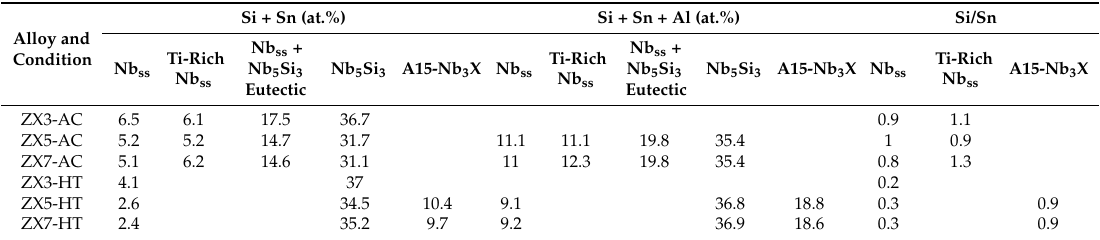
Table 6. Comparison of Nb ss , Ti-rich Nb ss , Nb 5 Si 3 , Nb ss + Nb 5 Si 3 eutectic, and A15 phases in the alloys ZX3, ZX5, and ZX7.